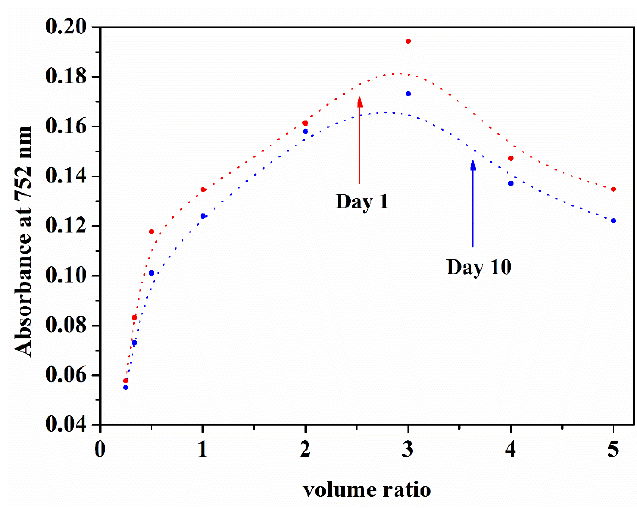
Figure 8. Absorbance at 752 nm of different volume ratios (CUR/PC).